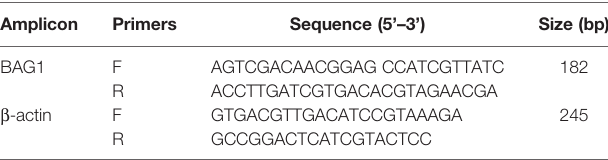
TABLE 1 | The oligonucleotide primers applied for real-time PCR.